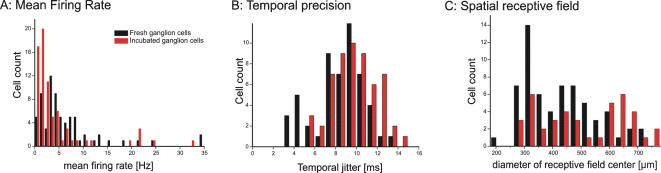
Electrophysiological properties of ganglion cells in incubated retinas are comparable to properties of freshly prepared ganglion cells.(A) Histogram of average firing rates for 69 ganglion cells from 5 retinas after 2 days (3 retinas) or 3 days (2 retinas) of incubation (red columns) and 73 ganglion cells from freshly prepared retinas (black columns). All cells were recorded with multielectrode arrays; the firing rate was calculated in response to spatial white noise (see Methods). The two distributions are similar, although more incubated cells are recorded with mean firing rates below 2 Hz. (B) Histogram of temporal jitter in response to the same spatially uniform temporal white noise stimulus. The temporal jitter distribution does not differ significantly (p<0.05, ANOVA) for the two populations. Mean temporal jitter was 10 milliseconds for incubated ganglion cells and 8.6 milliseconds for fresh ganglion cells. (C) The diameters of receptive field centers. Mean receptive field center was 520 µm for incubated ganglion cells (n = 43) and 430 µm for fresh ganglion cells (n = 73).